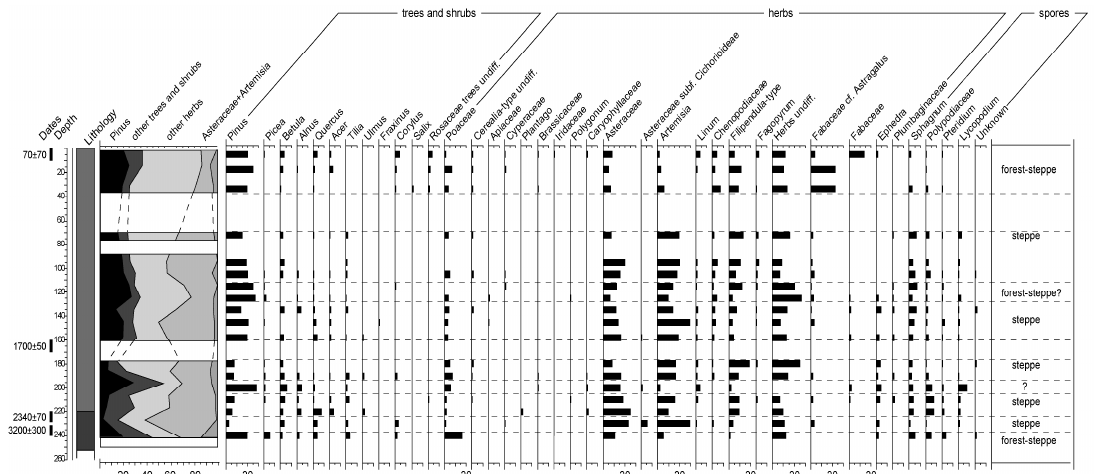
Figure 8. Pollen diagram of the section in the “Vishnyaki” gully, Yamskaya steppe site. Percentage of pollen groups are calculated from total amount of pollen; percentage of spores are calculated from total amount of pollen and spores.